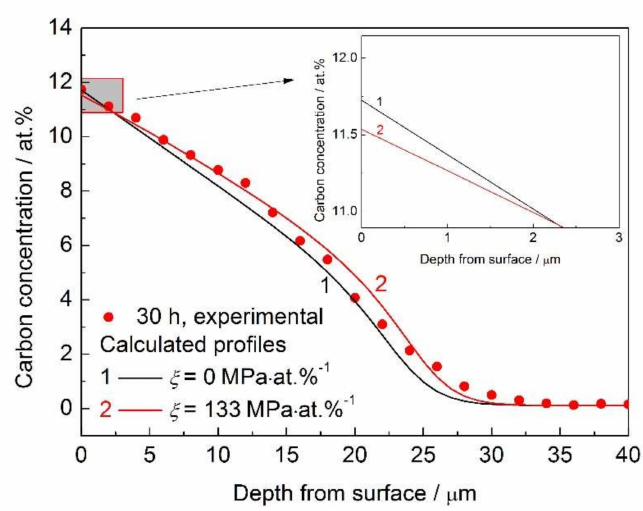
Figure 5. Calculated carbon concentration-depth profiles of AISI 316L carburized at 470 ◦ C for 30 h using different values of ξ .